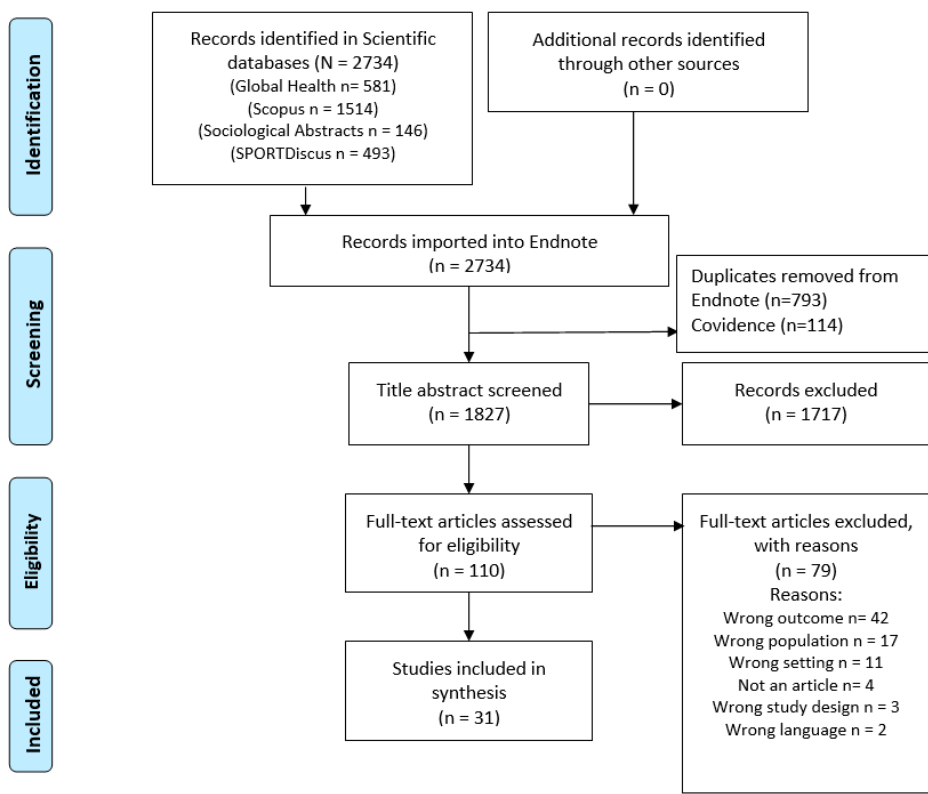
Figure 1. Flowchart of research